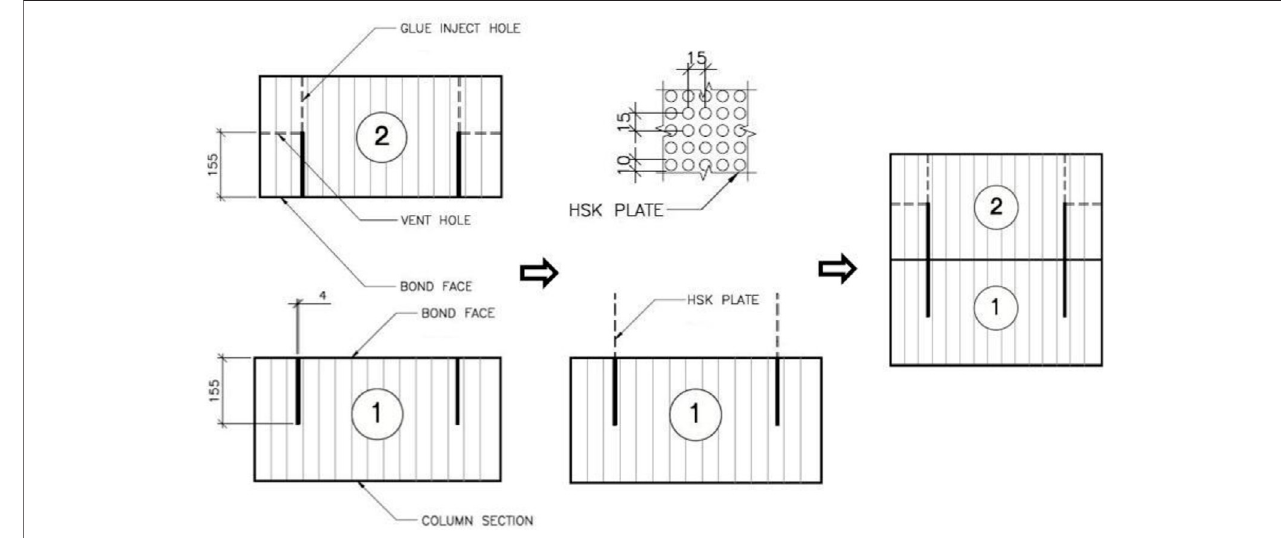
FIGURE 7 | Installation procedure for HSK composite Glulam Column.